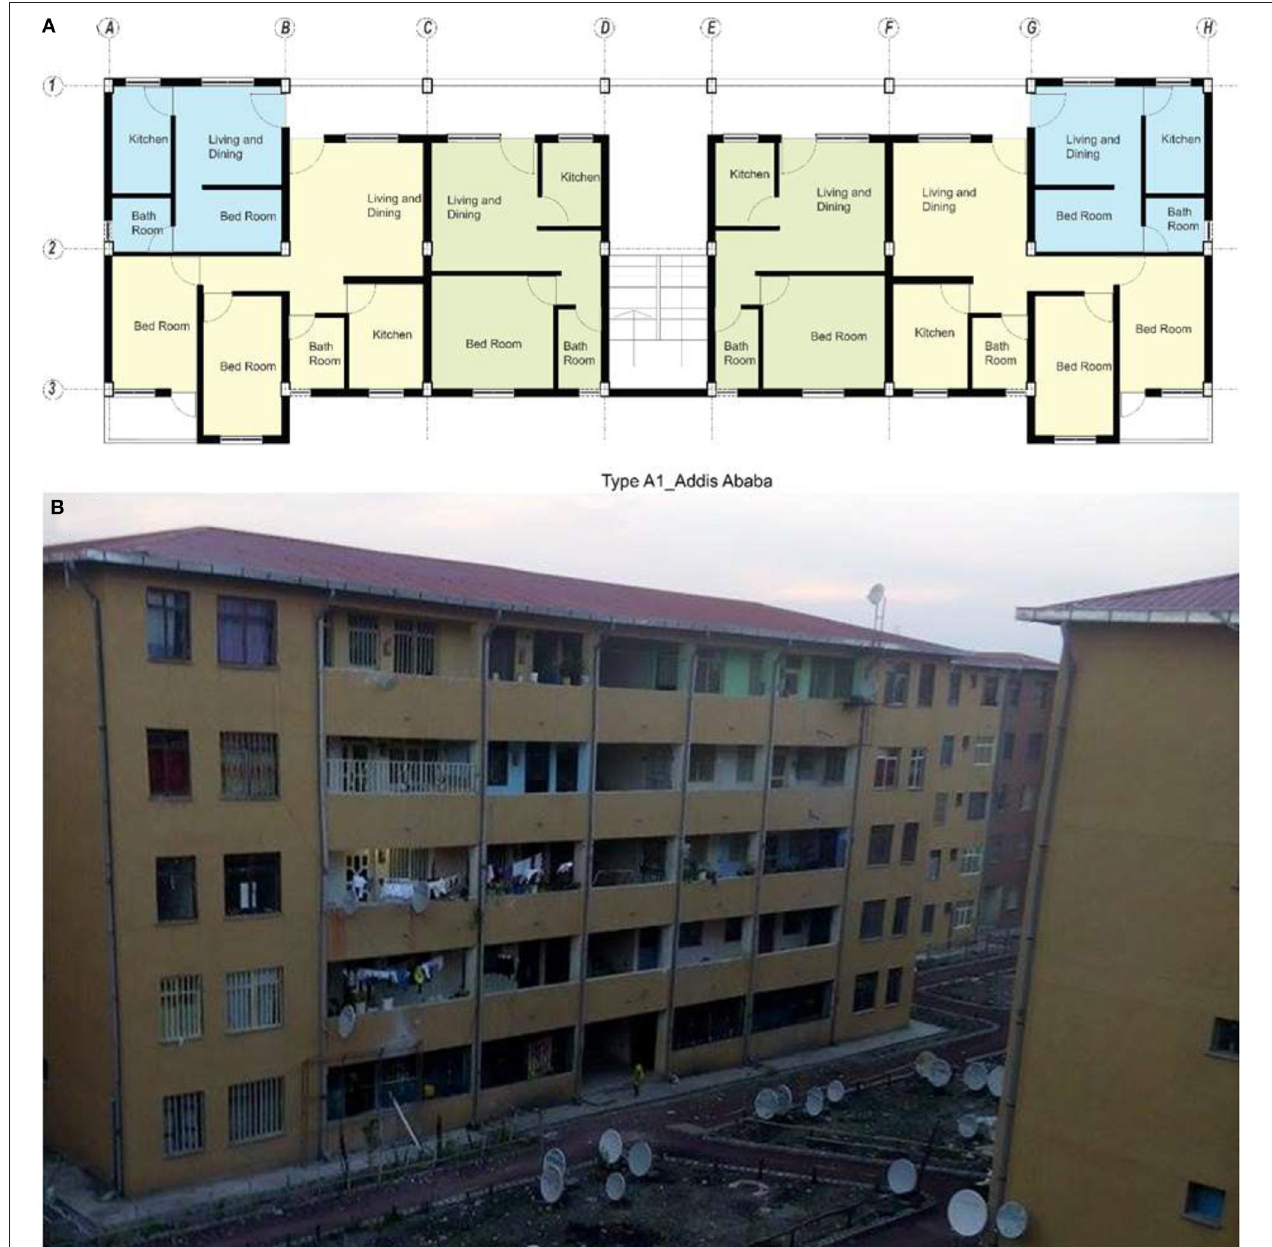
SST measures the total sum of squared differences, and SSE represents sum of the squared errors in i t h group, reflects within- group